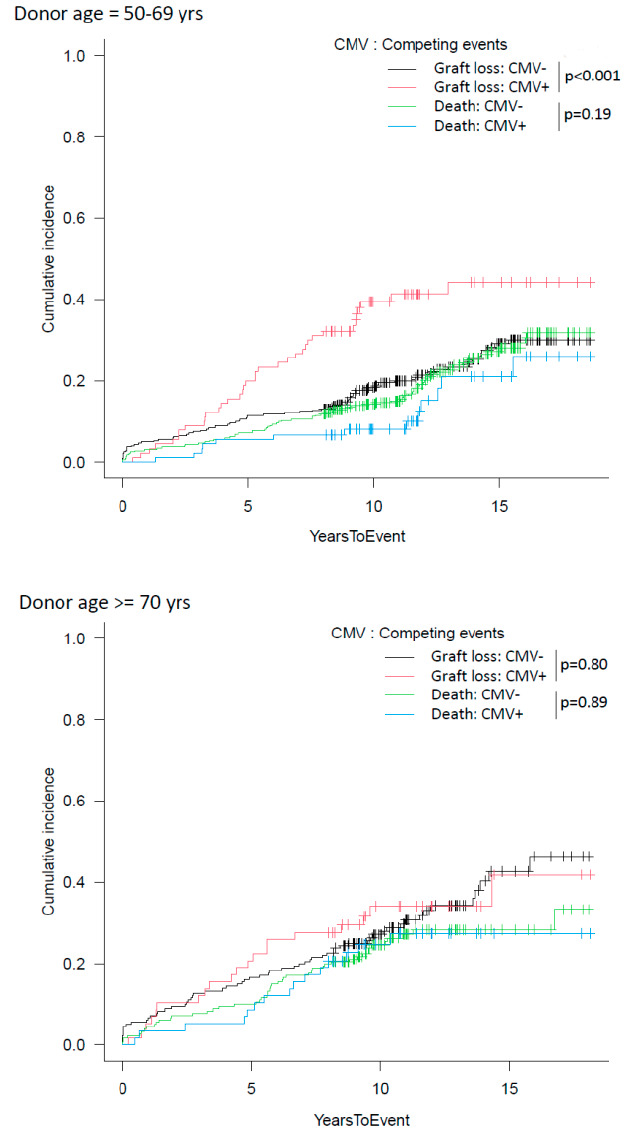
Figure 6. Cumulative incidence of graft loss, accounting for death as a competing risk, in patients with/without CMV replication/disease in the first year after transplantation stratified for donors <50 years, 50–69 years, or ≥ 70